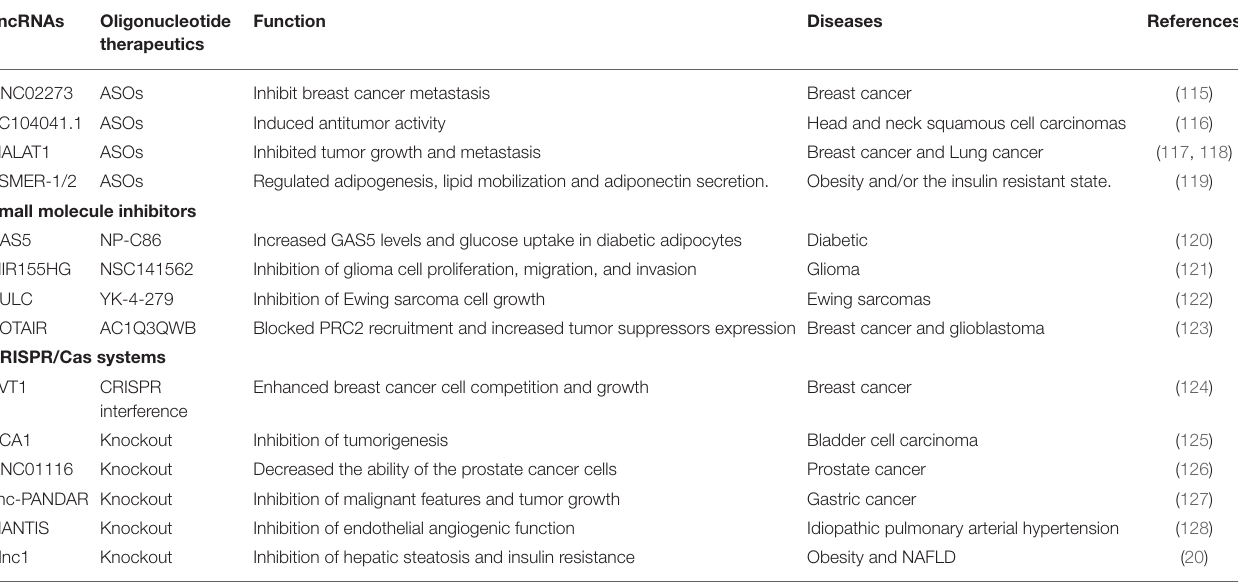
TABLE 2 | Therapeutic aspects of lncRNAs in various diseases with oligonucleotide therapeutics.